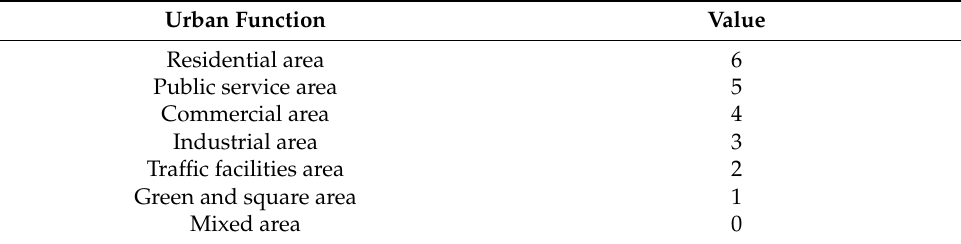
Figure 9. Urban functional features of basic road units. Table 3. The values of urban functional feature.